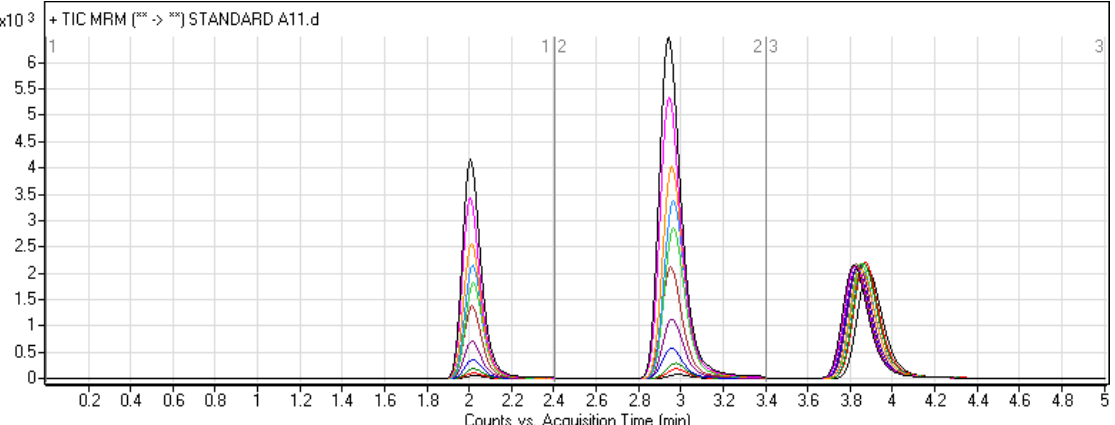
Figure 4. Overlayed TIC chromatograms of MRM of LE300 (1–200 ng/mL), MLE300 (2–200 ng/mL), and IS (20 ng/mL).